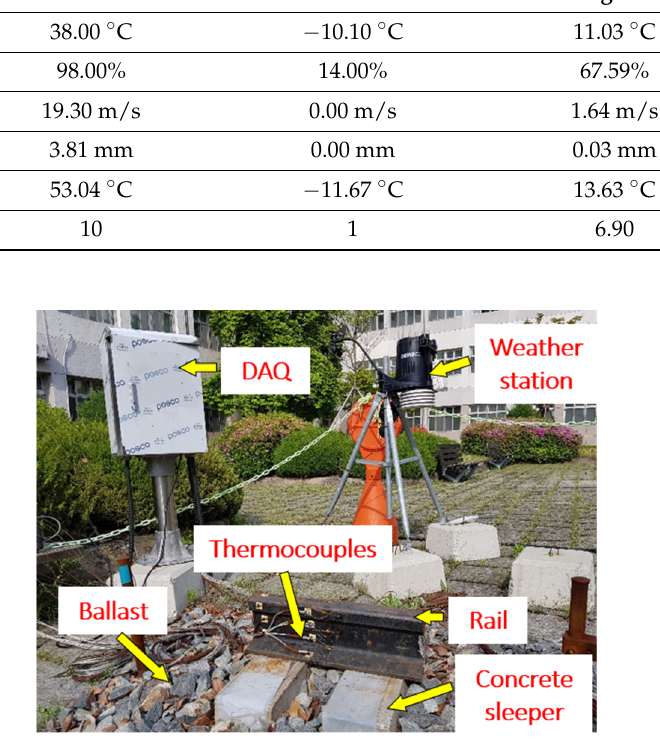
Figure A1. The installed measurement system.